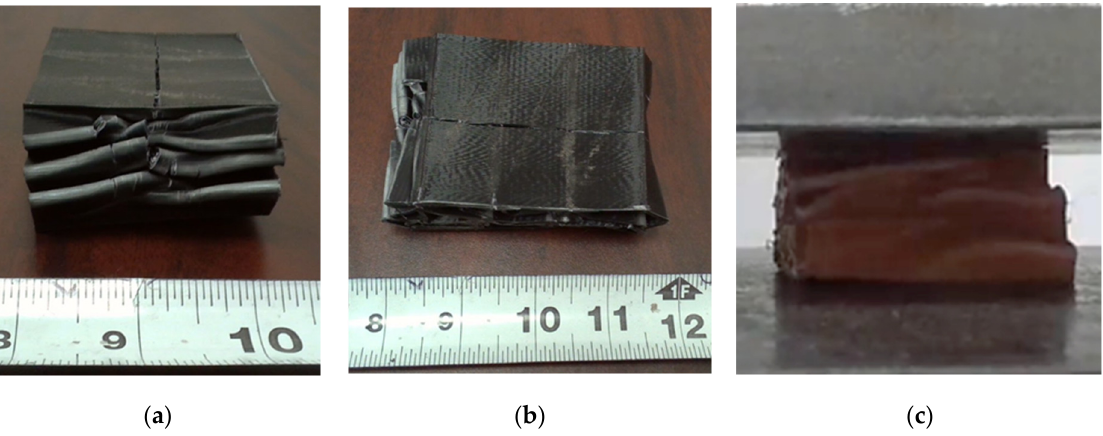
Figure 23. ( a , b ) Transversal crack on the whole width of a large ‐ scale novel experimental sample after lateral compression; and ( c ) regular scale, experimental sample at densification during lateral compression, with absence of the transversal crack.